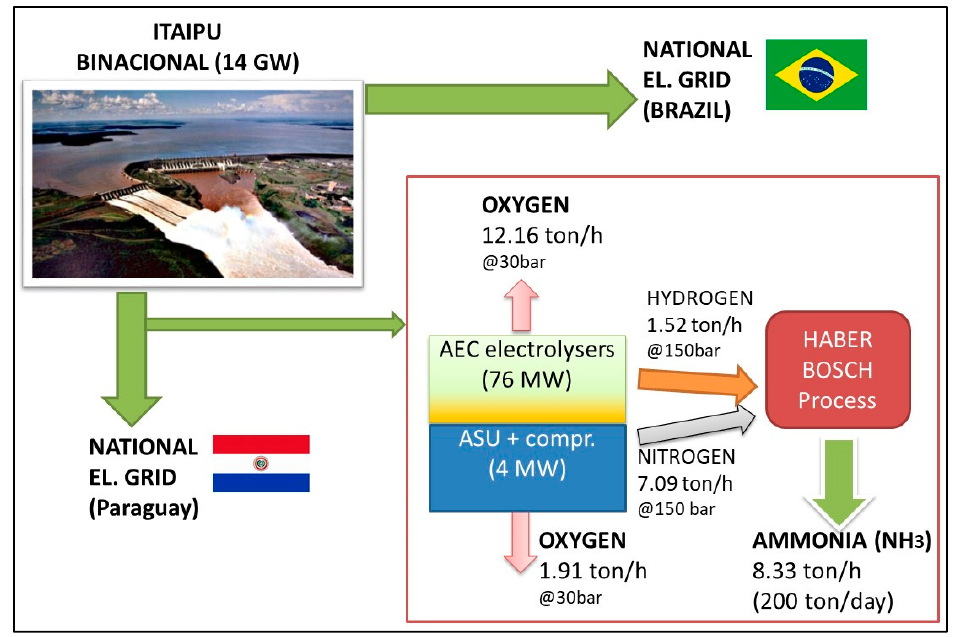
Figure 3. Simplified scheme for ammonia synthesis from Itaipu electrical energy.